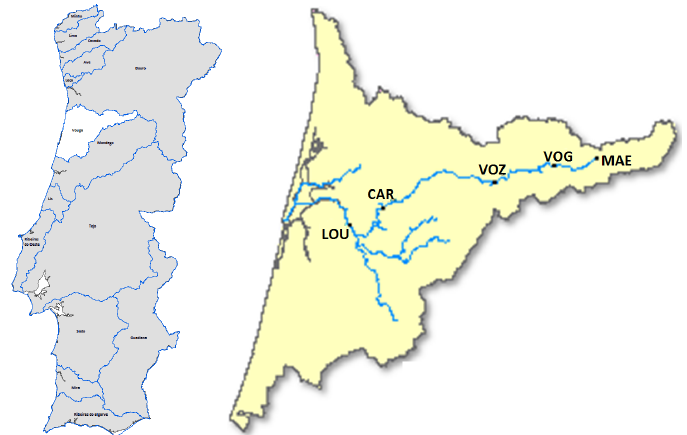
Figure 1. The hydrological basin of river Vouga location in Portugal and locations of monitoring sites, based on maps of the Portuguese National Information System for Water Resources (SNIRH) [31].